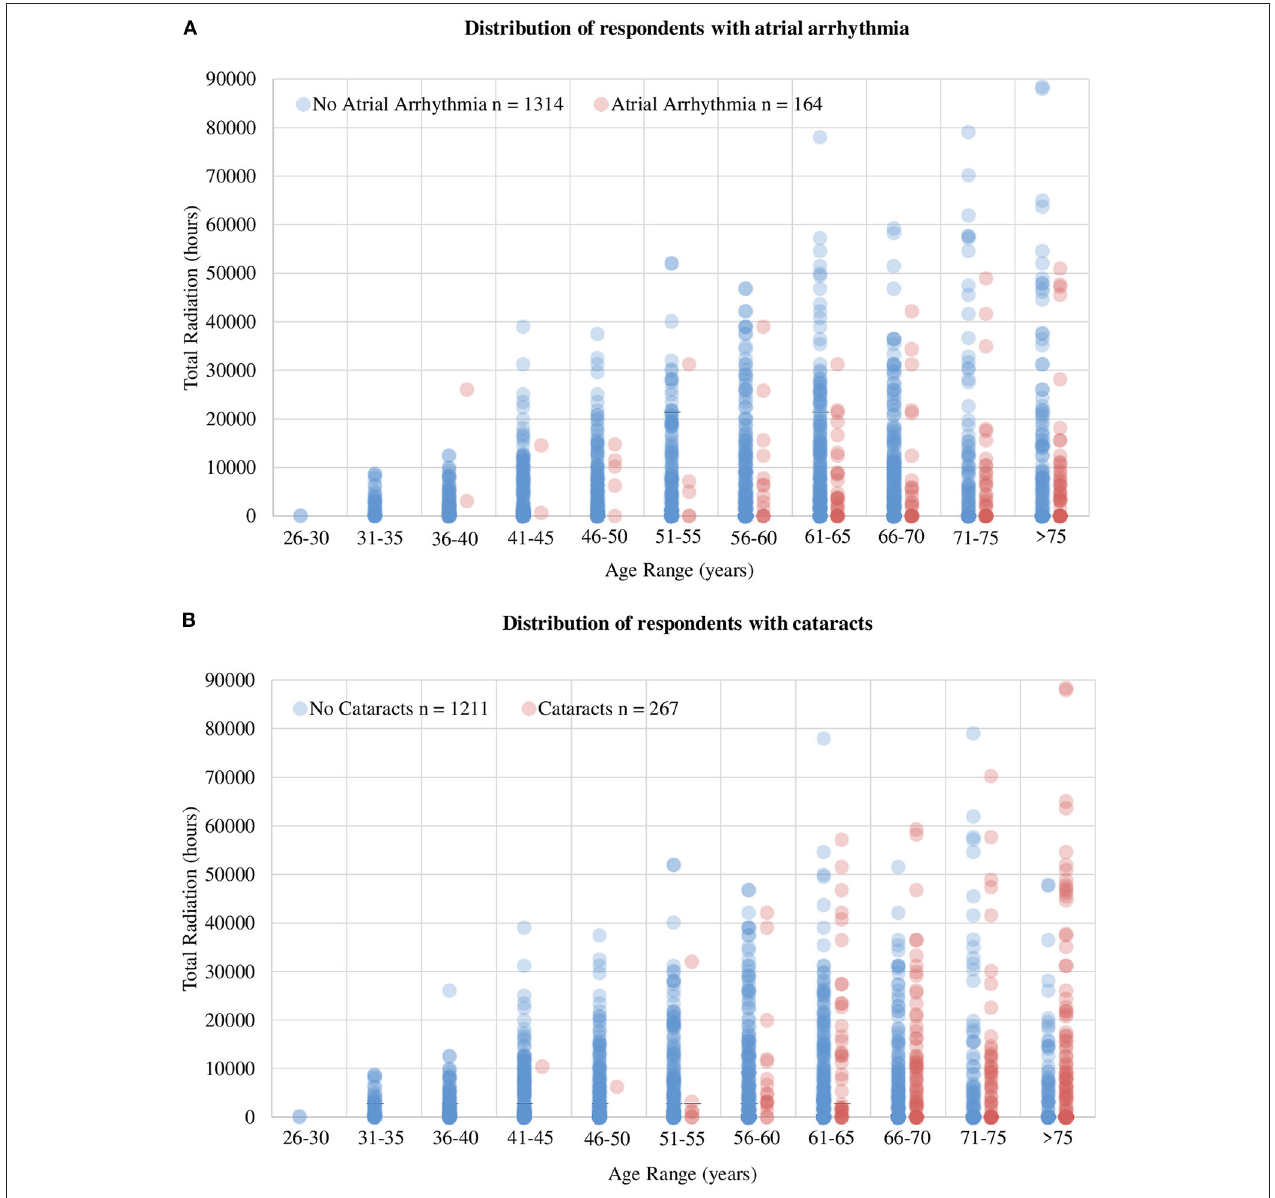
FIGURE 2 | Distribution of respondents with AA and cataracts. (A) Total number of radiation hours per age group in cardiologists reporting AA and those without AA. It exhibits a clear delineation of number of cases of AA around 10,000h of radiation and 50 years of age, leading to the thresholds used to stratify response during analysis. (B) The influence of age and total radiation hours on the prevalence of cataracts. The influence of increasing age on the prevalence of cataracts is evident but more importantly, note the increased prevalence of cataracts with increasing total hours of radiation, indicating the accuracy of the dataset collected as well